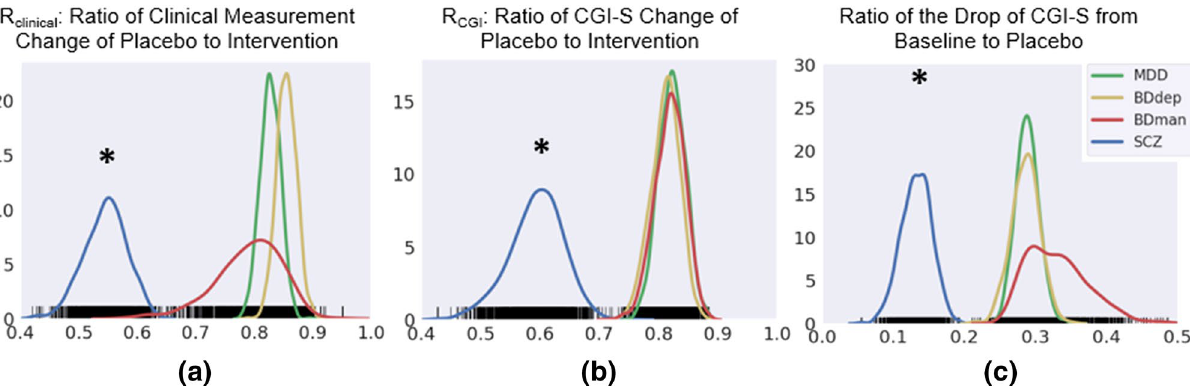
Figure 3. Differential placebo effect for SCZ, BDman, BDdep and MDD, as confirmed by sample-size weighted bootstrapping using ( a ) the ratio of clinical measurement change from baseline for placebo to intervention, ( b ) ratio of CGI-S change from baseline for placebo to intervention, and ( c ) ratio of CGI-S decrease from baseline to the CGI-S value at the baseline for placebo. The placebo effect was always greater than zero, while less than one, meaning patients could not fully recover or achieve improvement comparable to intervention by just taking placebo. The placebo effect for SCZ is significantly lower than that for MDD and BD. *Denotes significant difference from other distributions at P <